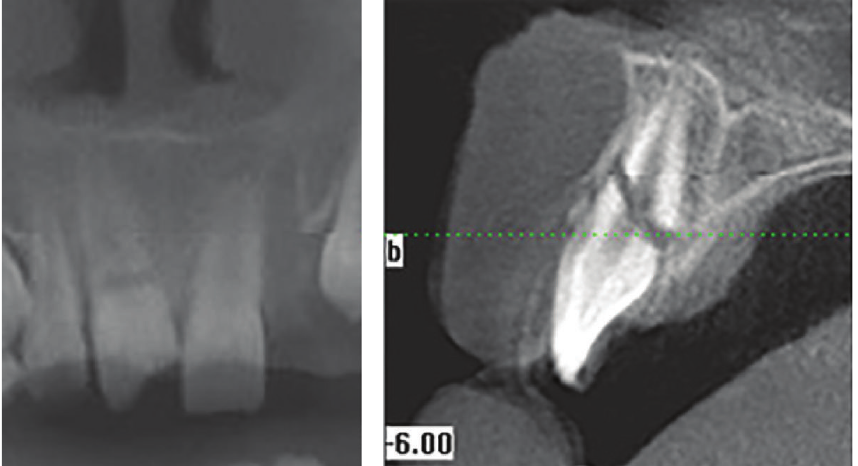
Figure 5: Cross-sectional and coronal view of the horizontal root